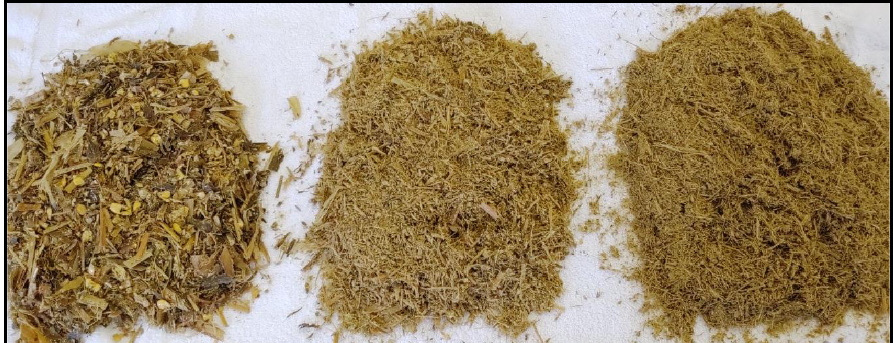
Figure 2. Whole-plant corn (after ensiling) processed with an on-board kernel processor (left — KP treatment) or with the experimental processor either once (middle — 1X treatment) or twice (right — treatment) or with the experimental processor either once (middle—1X treatment) or twice (right—2X 2X treatment). Processing took place prior to ensiling. treatment). Processing took place prior to